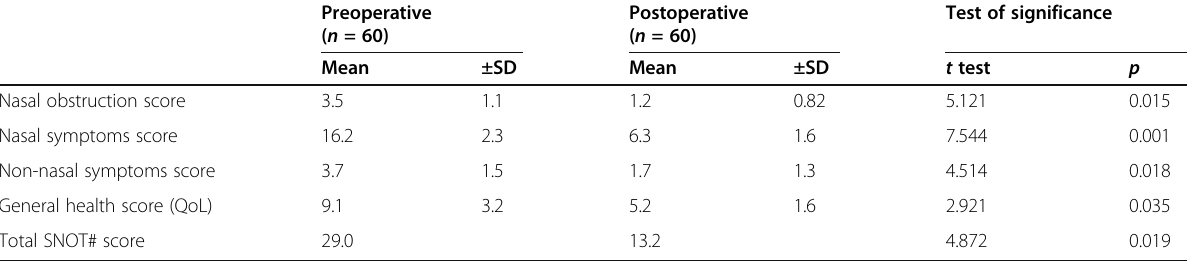
Table 4 Statistical analysis of SNOT-22 score pre- and postoperative